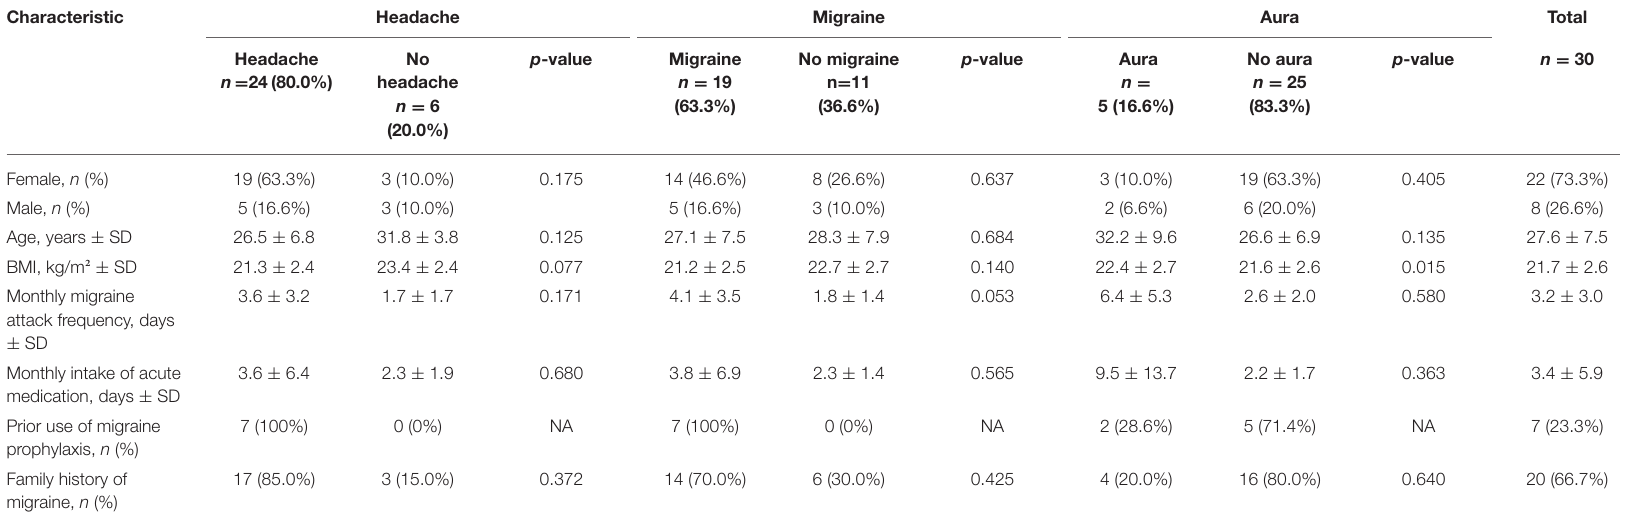
TABLE 1 | Baseline characteristics of participants allocated to headache-type group under hypoxia. Characteristic